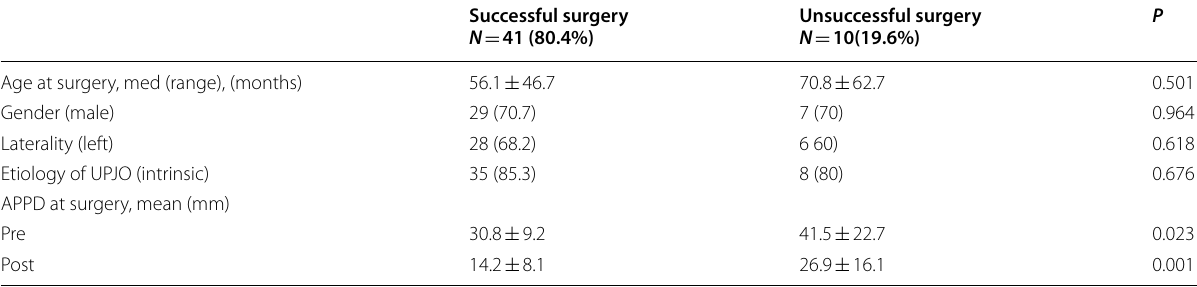
Table 2 Difference between successful and unsuccessful groups of patients